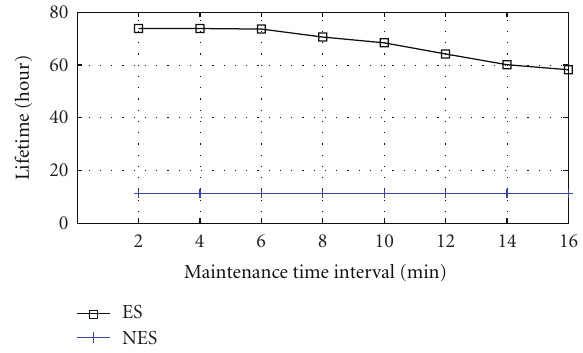
Figure 17: Impact of maintenance time